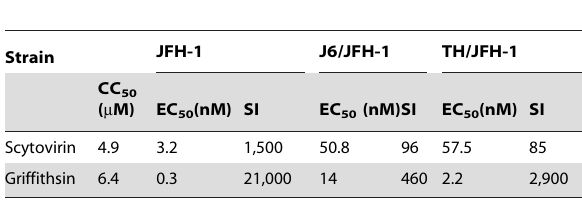
Table 2. Inhibitory effect of scytovirin and griffithsin on the replication of JFH-1 and HCVcc chimera.